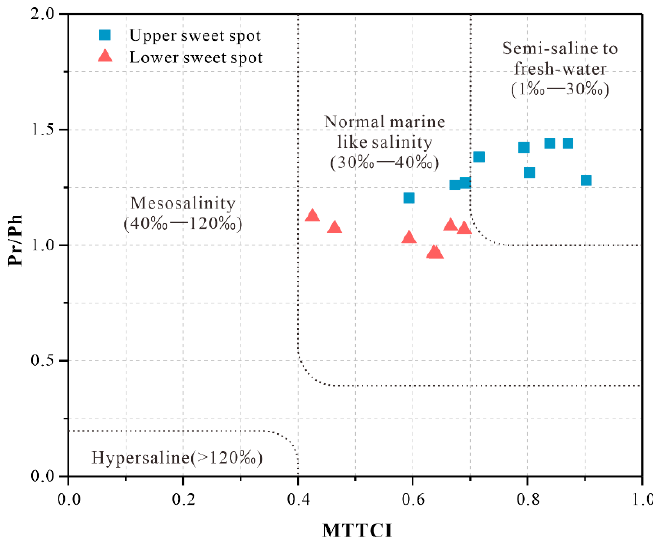
Figure 10. Correlation of Pr/Ph vs. MTTCI and lacustrine water salinity assessment of the Lucaogou formation [70].